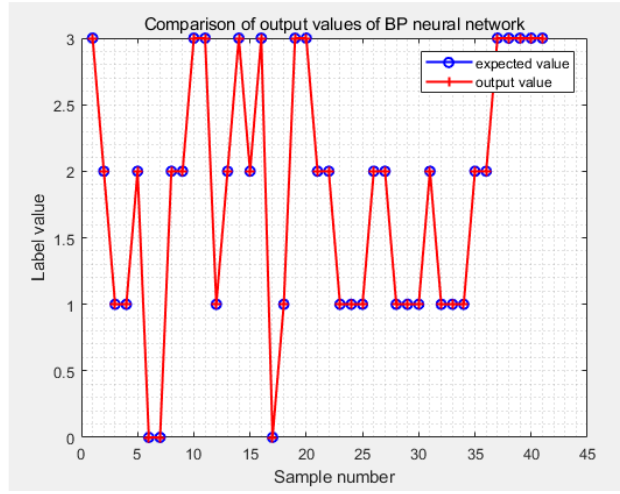
Figure 6. Network training performance analysis chart.